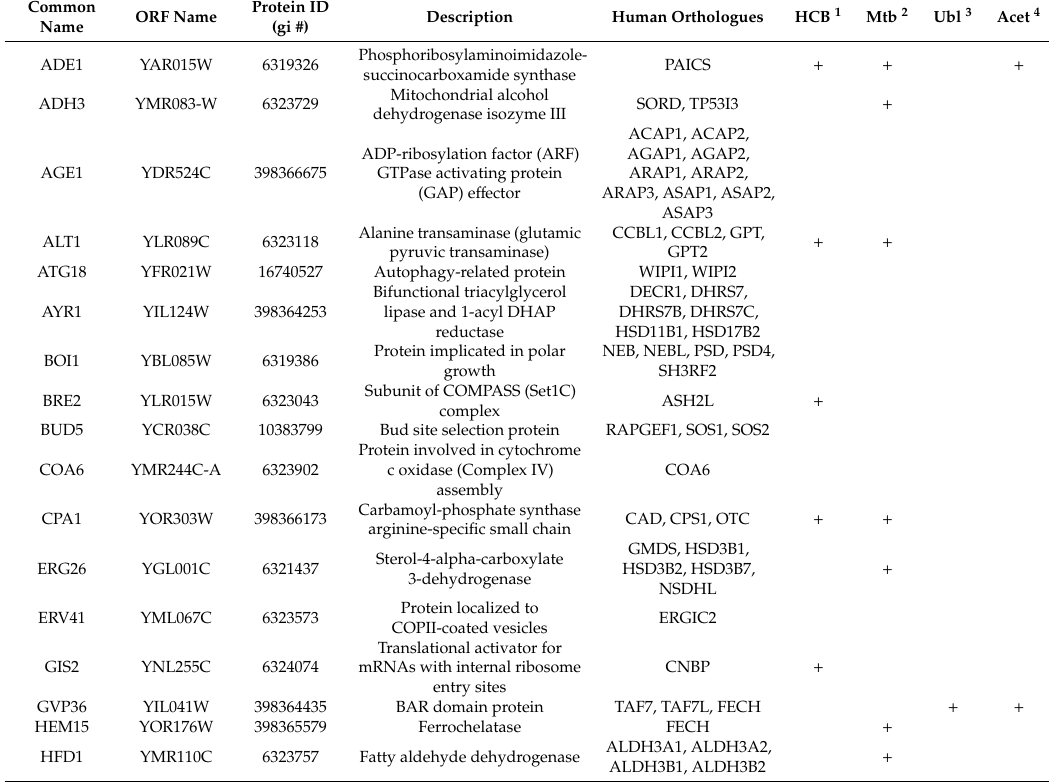
Table 2. List of bound proteins found only in extracts from normoxic or heme-su ffi cient